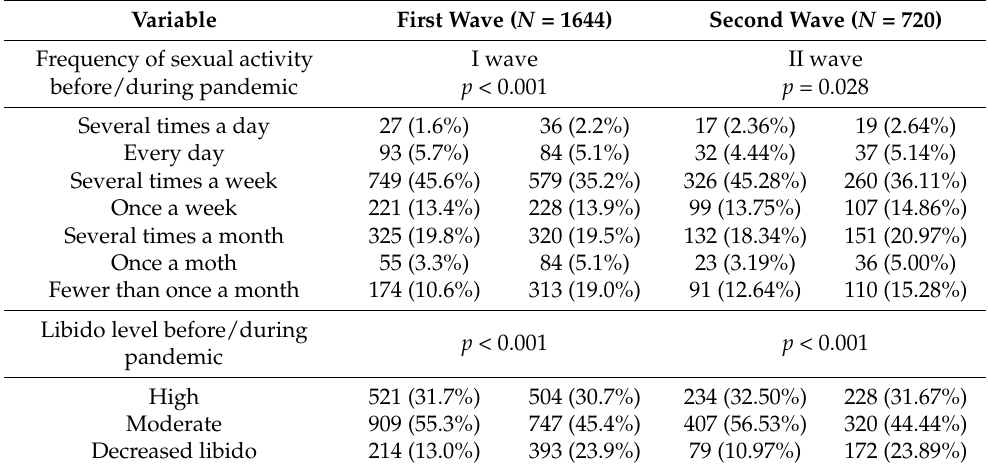
Table 1. Sexual status characteristics of the study group during the first and second wave of the COVID-19